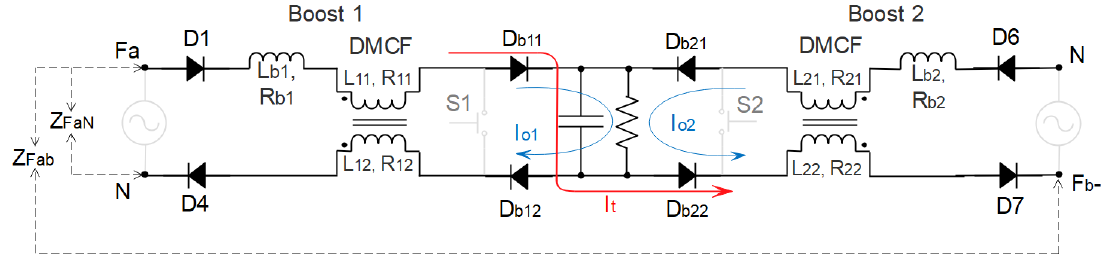
Figure 6. Representation of the analysis of current interaction mitigation in the proposed rectifier. Here, F a and F b represent the phase a and b terminals, Z FaN is the phase a impedance with neutral, Z Fab is the impedance in the combination of the phase a with phase b, L b is the boost inductor, R is the resistance, and L is the inductor.